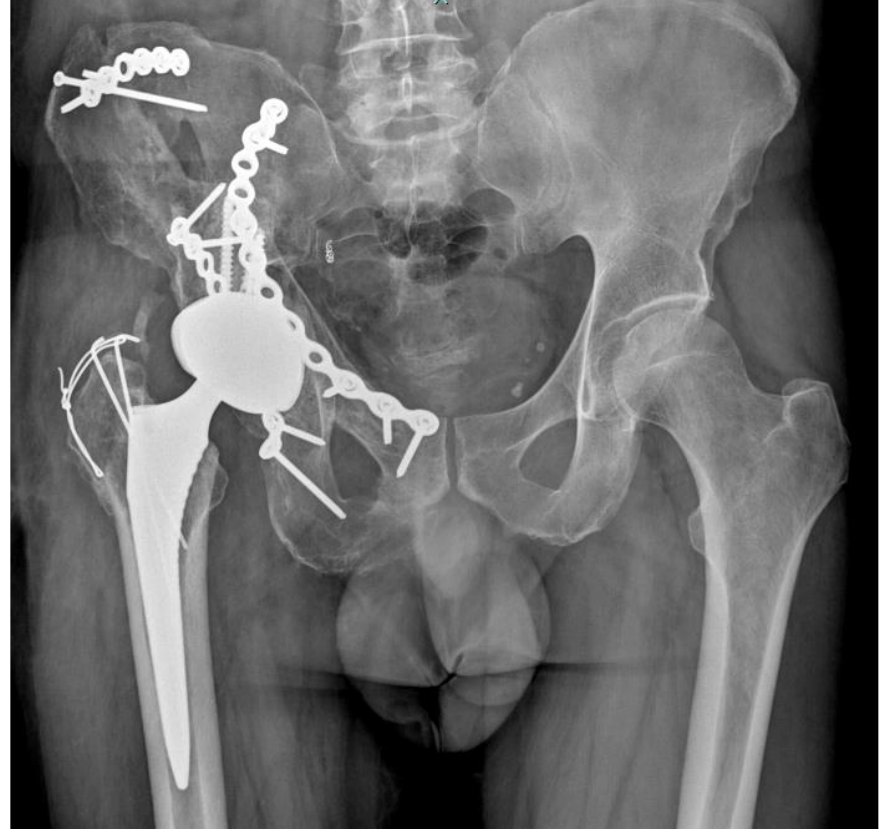
Figure 5. X-ray of the pelvis after the implant of total hip arthroplasty. Postoperatively, the patient had no weight-bearing activity for one month despite the total hip arthroplasty. Prophylaxis for heterotopic calcification was set. The mobilization of the right hip was immediately allowed with no limits. After one month, gradual weight- bearing was allowed with the goal of total weight-bearing at two months. One year after the last surgical procedure, the patient had no symptoms, a compara- ble range of motion of the right hip to the left hip and was fully weight-bearing with no walking aids. An EQ-5D-3L score of 1.000 was observed. 3. Discussion Fracture-related infection of the pelvis can be considered a difficult challenge for or- thopaedic surgeons. Many conditions must be regarded for its treatment, and different strategies are involved. The medical team must carefully analyze factors, such as the ana- tomical region, nonunion of fracture, antibiotic therapy, and type of patient. The pelvic region is full of pitfalls, and they increase when a fracture-related infection occurs: previous trauma can change the normal anatomy and alter the relationships be- tween anatomical structures of the region; furthermore, the presence of infection makes the discrimination between healthy and pathological tissue very tricky. In our case report, the anatomy of the pelvic region was subverted, and there was significant bone loss: it was impossible to restore the original anatomy, so our osteosyn- thesis aimed to restore the function of the acetabulum. Based on the principle of Y-shape for acetabulum conformation [18], we restored the two columns to fit the acetabular cup. 3D reconstruction and the 3D-printed model played a leading role. According to recent literature, using a 3D-printed model helps orthopaedic surgeons understand the spatial